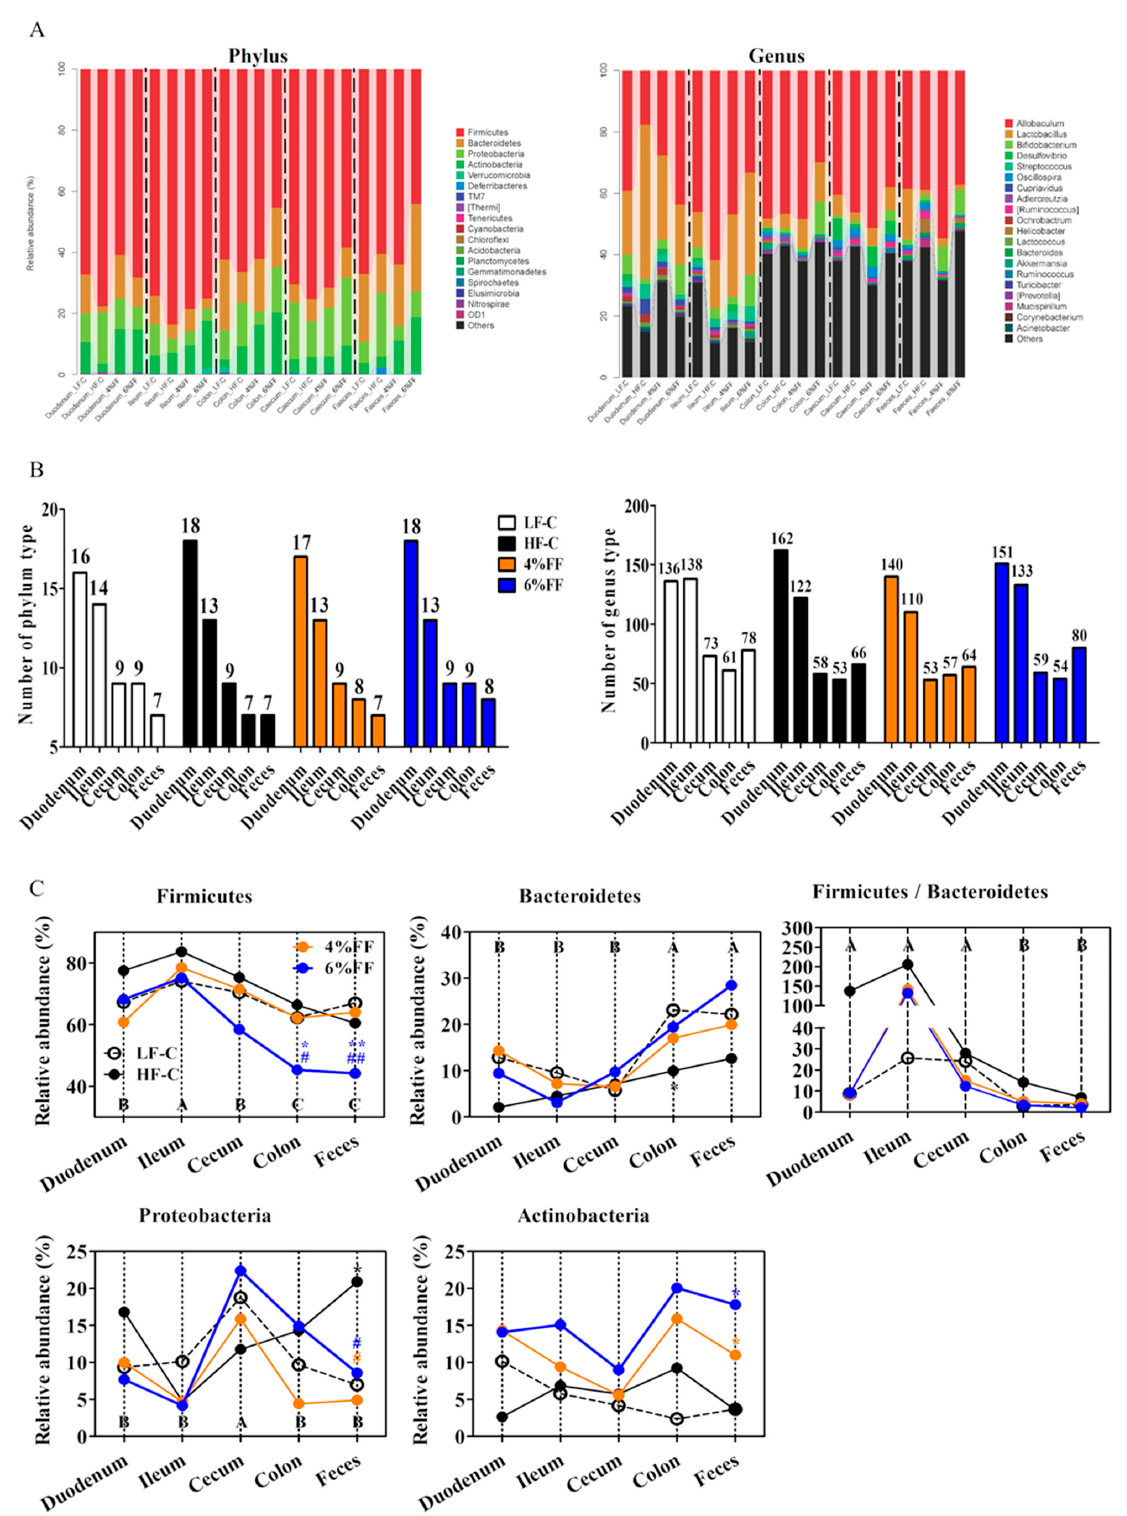
Figure 6. Microbiota composition at phylum and genus levels: ( A ) taxonomic distribution of bacterial phyla and genera, ( B ) numbers of phyla and genera in microbial composition, and ( C ) changes in relative abundance of the most dominant phyla ( Firmicutes , Bacteroidetes , Proteobacteria , Actinobacteria ) and Firmicutes / Bacteroidetes